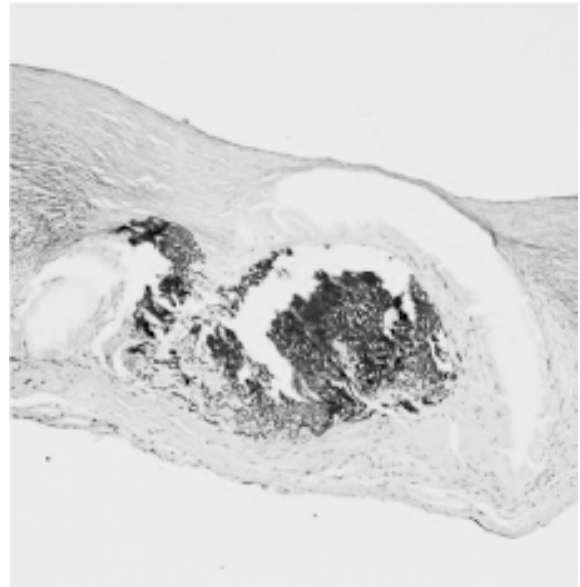
FIGURA 2 – Polidioxanone – Sutura contínua. Fio de sutura em degeneração, corado em rosa na periferia. (Calleja, 25 X – A.O.). Luz Arterial (L). Local do fio de sutura